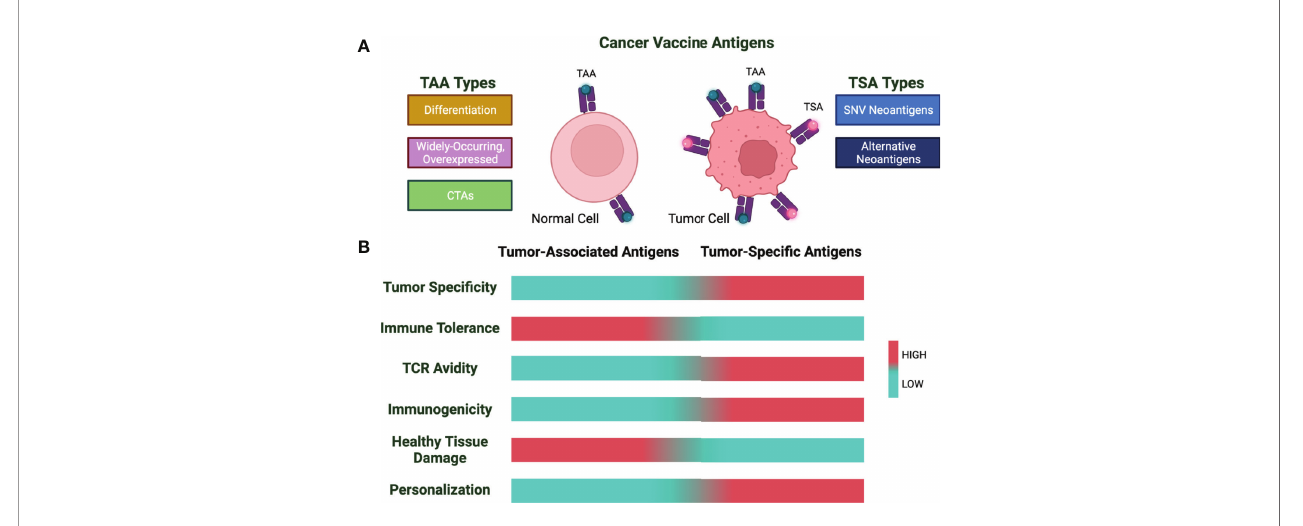
FIGURE 1 | Cancer vaccine antigen types and characteristics. (A) Cancer vaccine antigens are divided into tumor-associated antigens (TAA) and tumor-speci fi c antigens (TSA). Shown are subtypes of TAAs and TSAs. (B) Characteristics of TAAs and TSAs based on low (cyan) vs. high (red) for the indicated